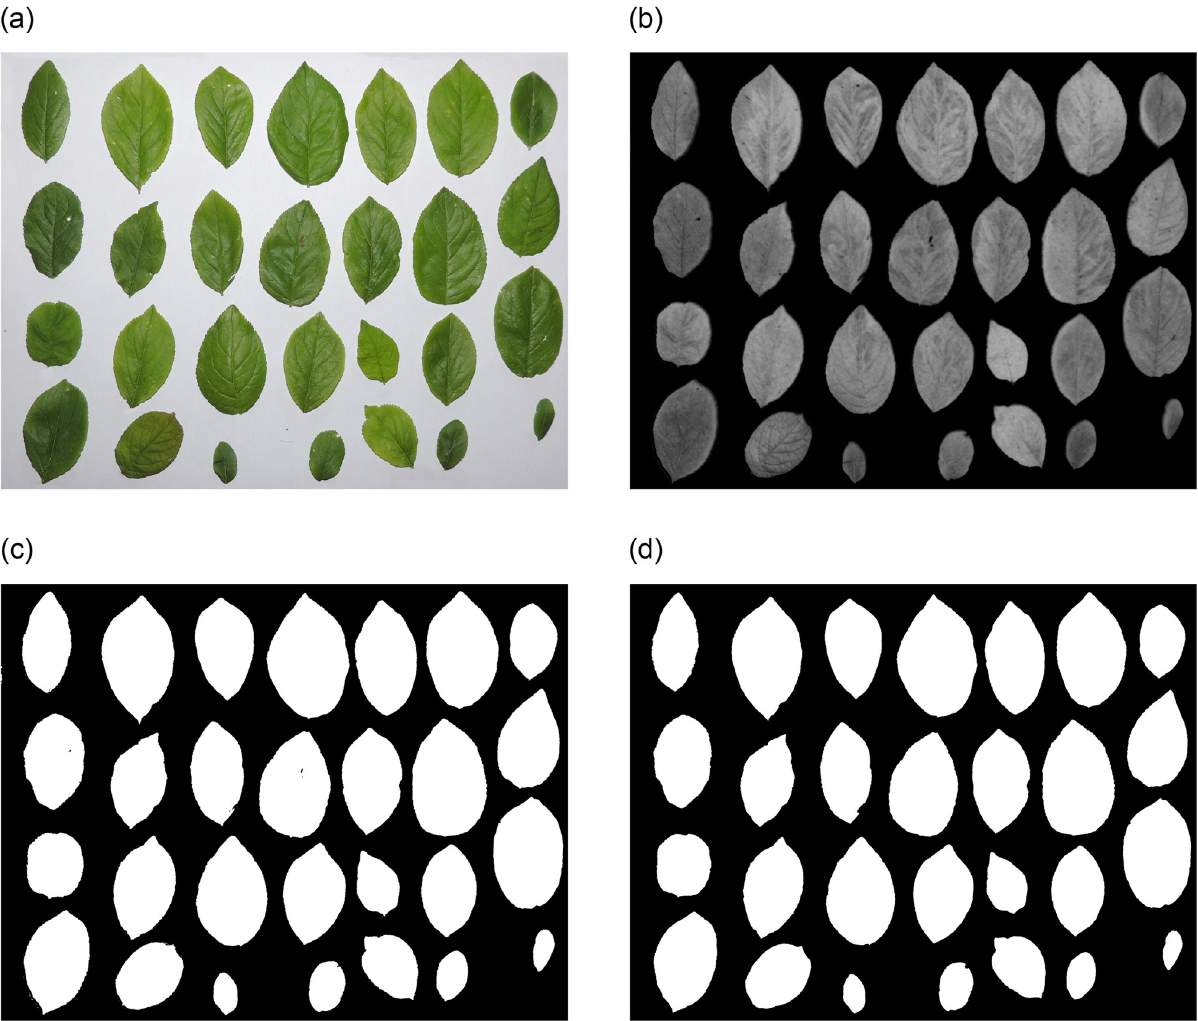
Fig 3. Results of image segmentation steps; a) primary RGB image, b) EXG image, c) first obtained binary image after implementing optimal threshold on the EXG image, and d) final binary image after removing small objects (noises) and filling inside leaf